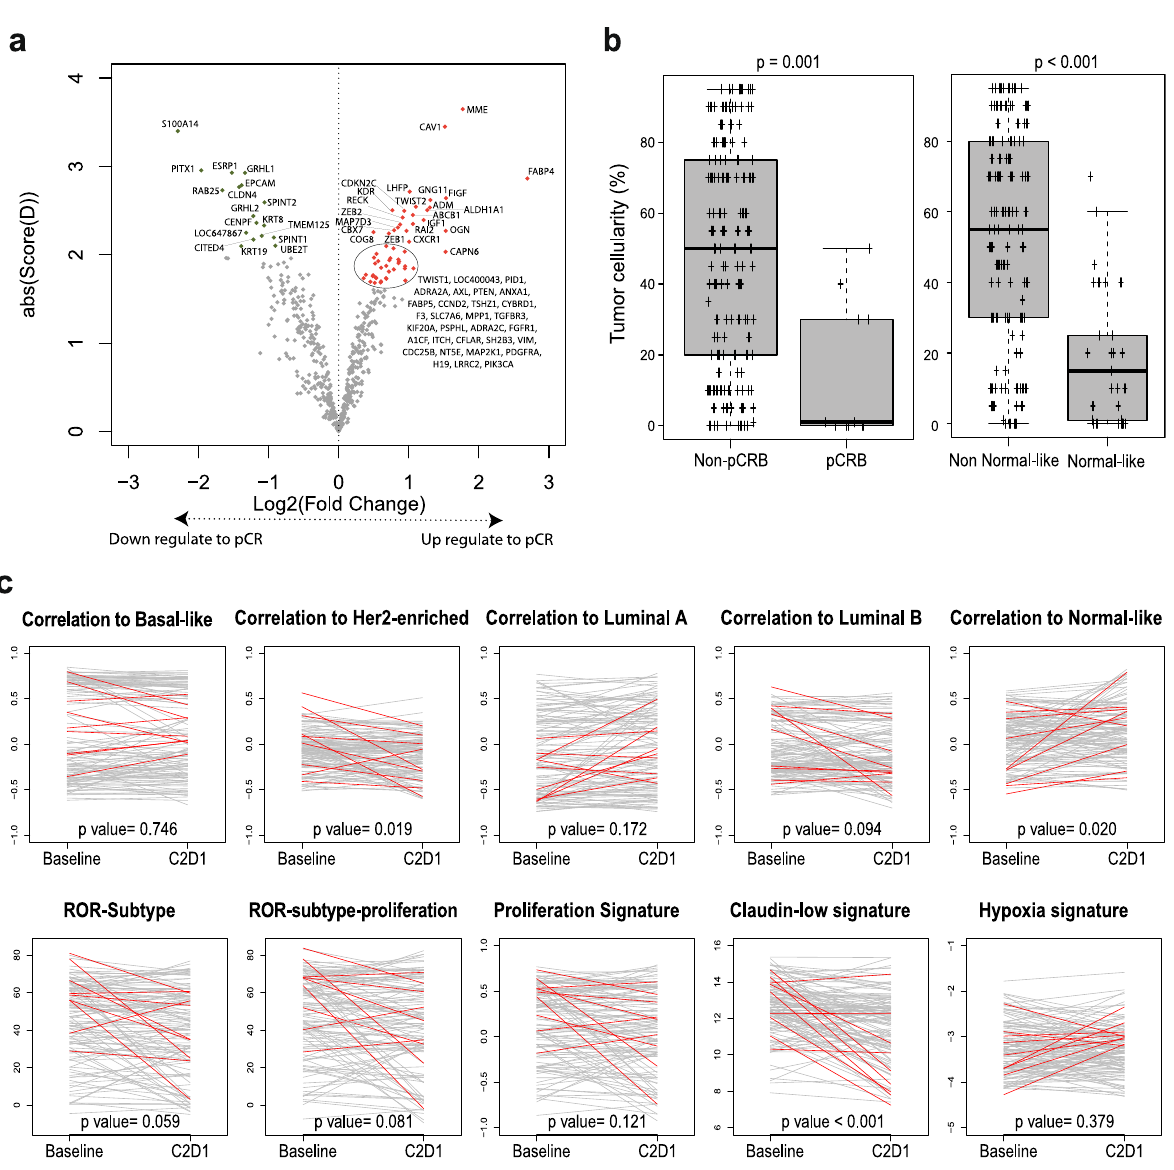
Fig. 5 Treatment activity based on Cycle2 Day 1 (C2D1) gene expression. a Genes found differentially expressed in C2D1 samples between pCR B and no-pCR B in SAM analysis. Colored dots mark the genes with a false discovery rate (FDR) = 0, in red upregulate and in green downregulated. b Percentage of tumor cellularity at C2D1 according with pathologic complete response (pCR) or residual disease